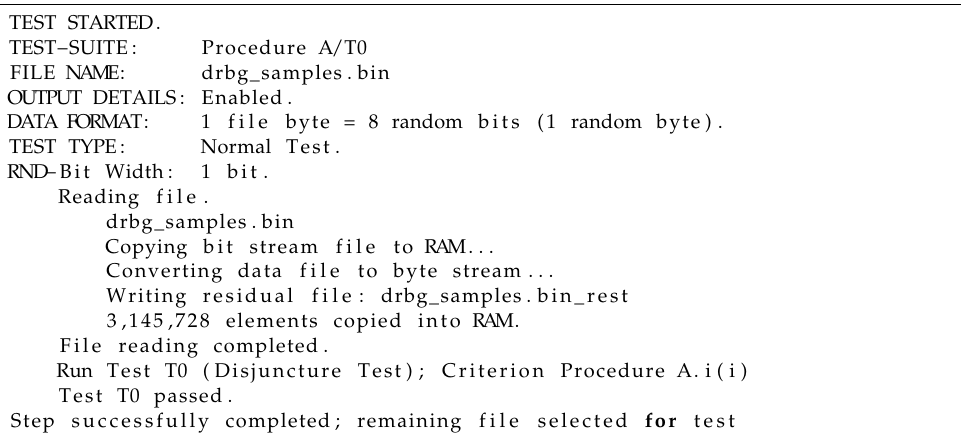
Figure 5. Flow diagram for randomness assessment when using the BSI suite (procedure A). Listing 4 . Output of procedure A (test T0 ) of the BSI